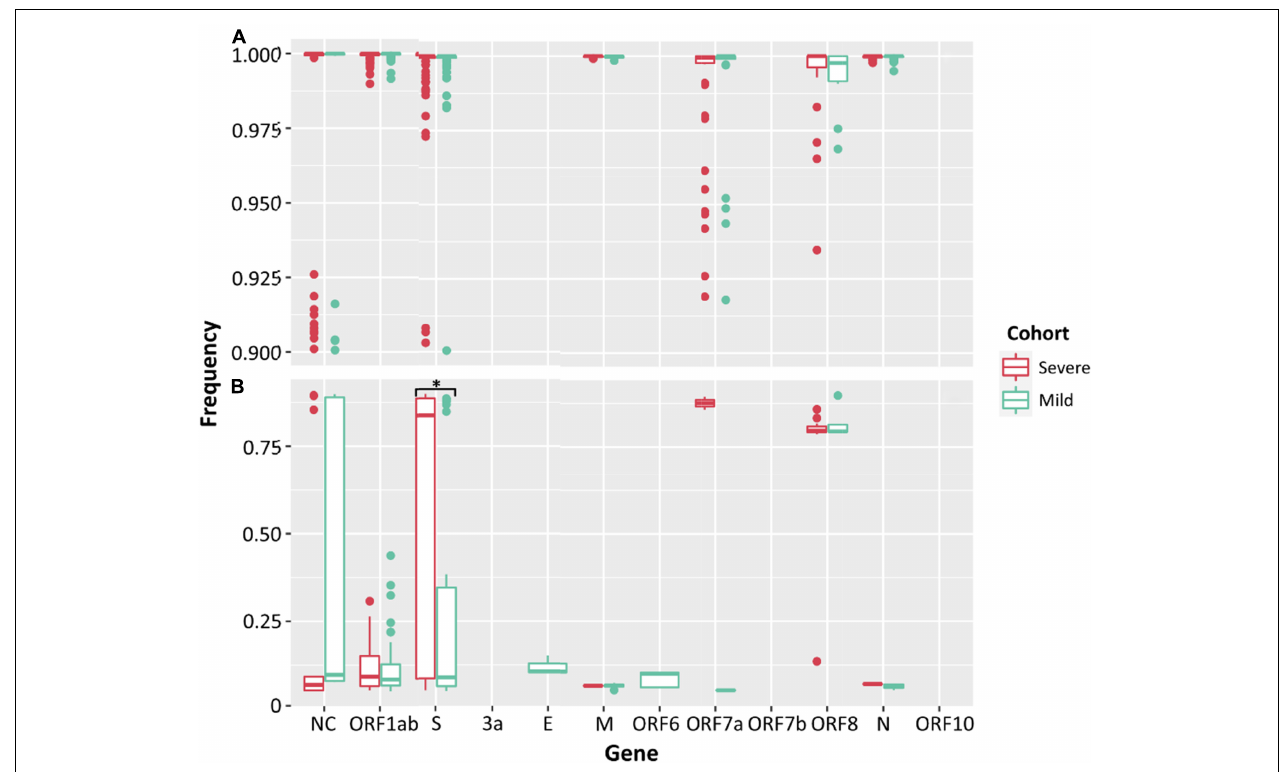
FIGURE 3 | Frequencies of SNPs (A) and iSNVs (B) by SARS-CoV-2 gene for severe (red) and mild (green) cohorts. Frequencies ≥ 0.9 were considered SNPs. Problematic sites are not included. NC signifies non-coding region of the genome. Statistical significance ( p ≤ 0.05) is denoted by ( ∗ ). The frequency of iSNVs in the spike gene of SARS-CoV-2 were significantly different between the severe and mild